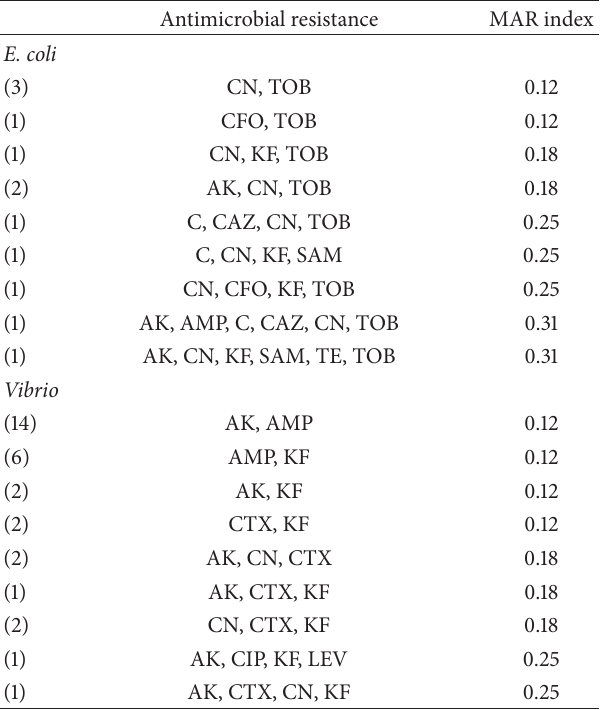
Table 6: Multiple antimicrobial resistance of E. coli and Vibrio strains found in